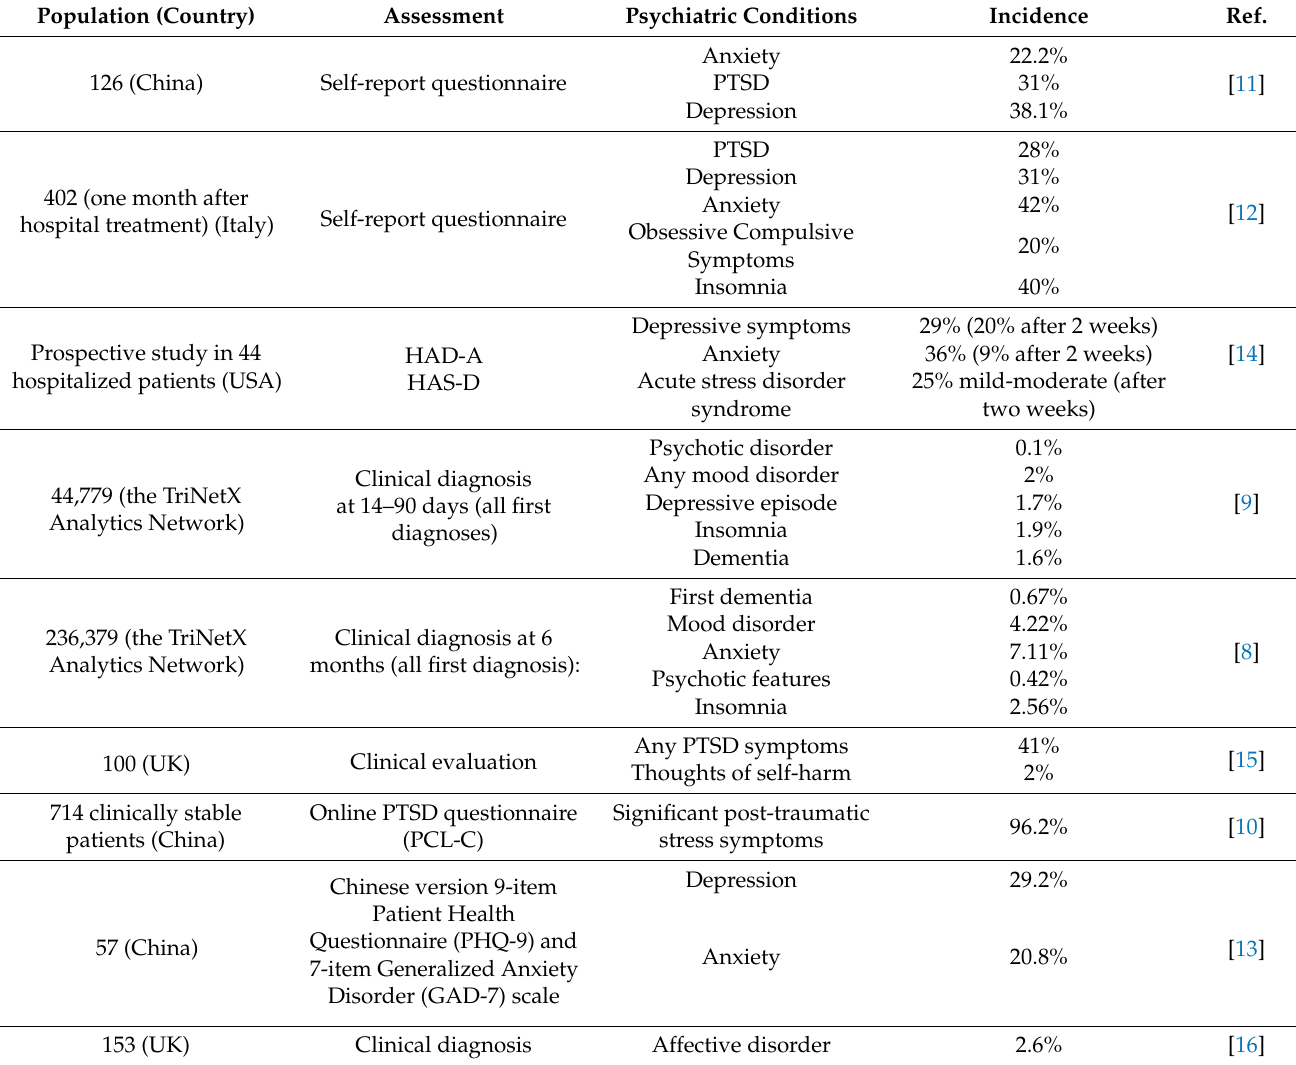
Table 1. Incidence of anxiety and depressive psychiatric conditions in patients with